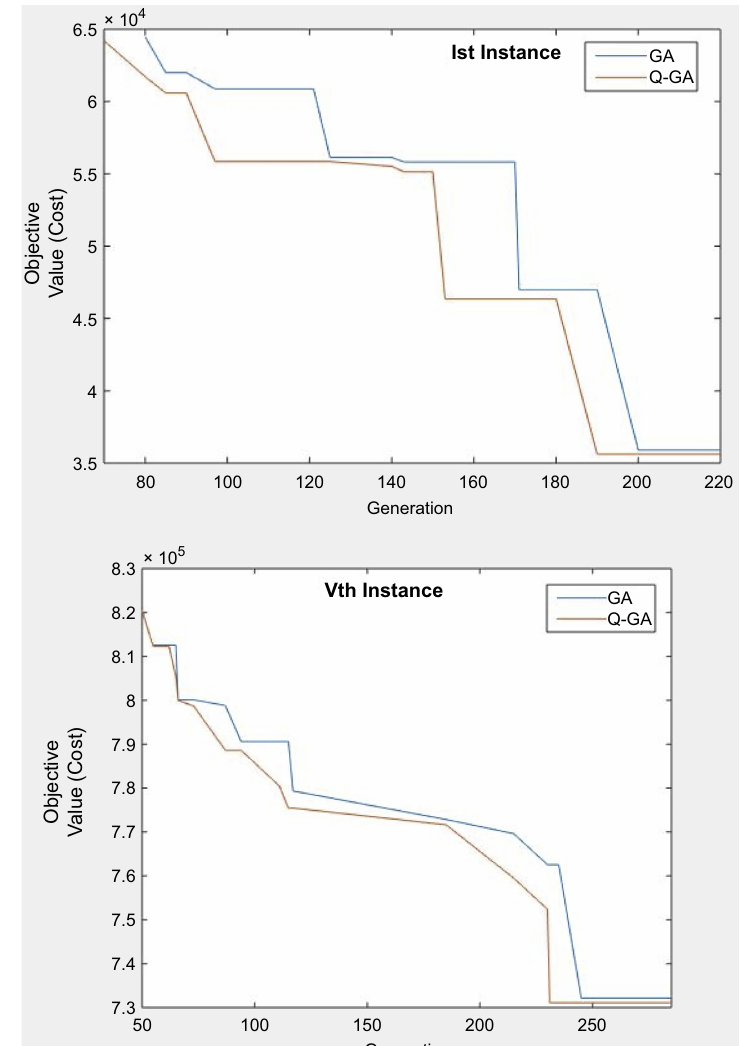
Figure 2. Convergence graphs for GA and Q-GA (Case Instance I and